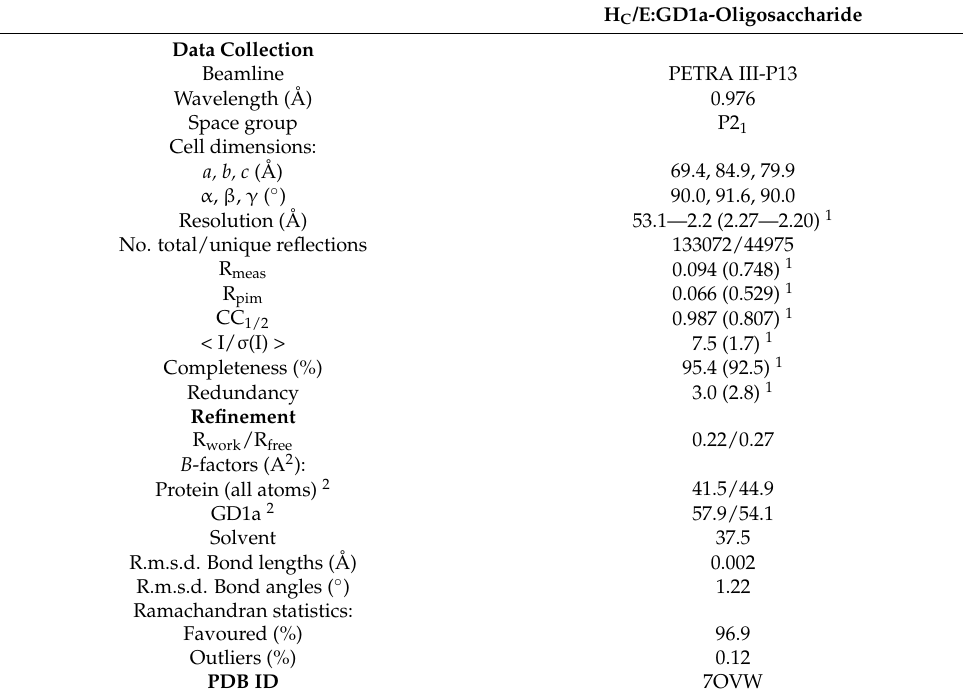
Table 1. Crystallographic Data Collection and Refinement.